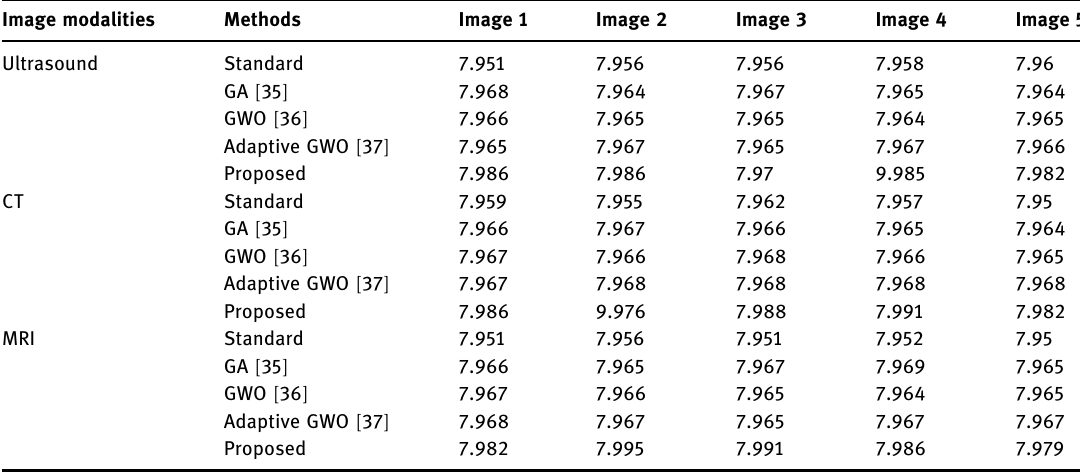
Table 5: Information entropy analysis of ultrasound, CT, and MRI images Image